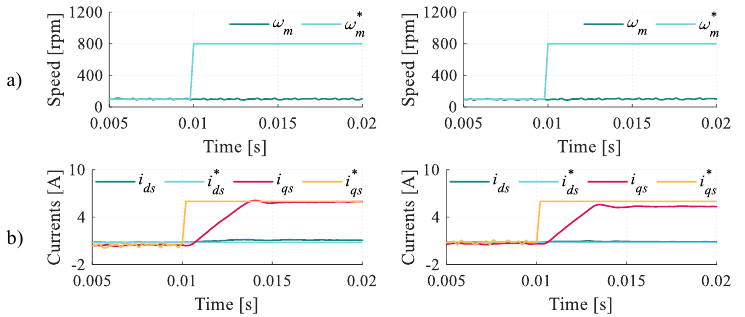
Figure X. Speed-step response of IRFOC SV-PWM (left) and IRFOC SV-PWM without Figure 10. Test 2. Speed-step response of IRFOC SV-PWM ( left ) and IRFOC SV-PWM without integral integral term in 𝑞 -current PI controller. From top to bottom: a) Mechanical speed, and b) 𝑑 - 𝑞 currents. term ( right ). From top to bottom: ( a ) Mechanical speed and ( b ) d - q currents.